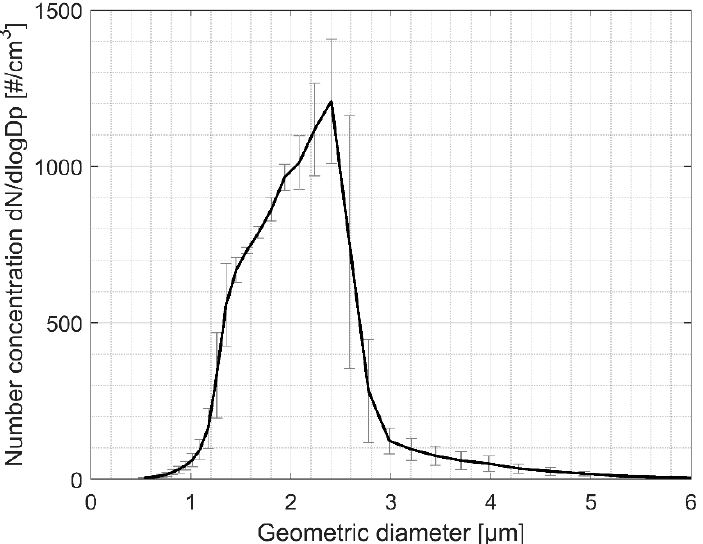
Figure A2. Dibutyl phthalate particle number concentration dN/dlogDp [#/cm 3 ] ± SD generated with a mean particle geometric diameter of 2.0 ± 0.05 µm SD with the modified TOPAS SLG270 aerosol generator. The aerodynamic diameter measured by APS is converted to the geometric diameter using the density of DBP.